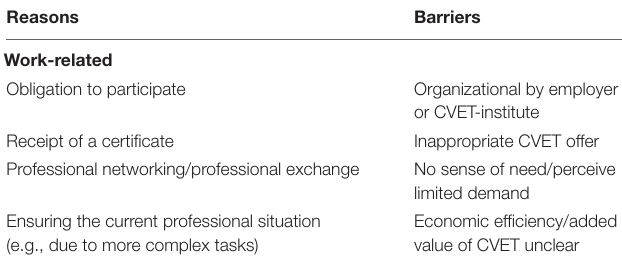
TABLE 3 | Overview of